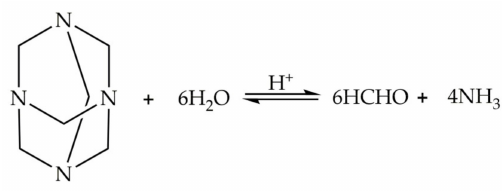
Figure 1. Hydrolytic process of HMTA.